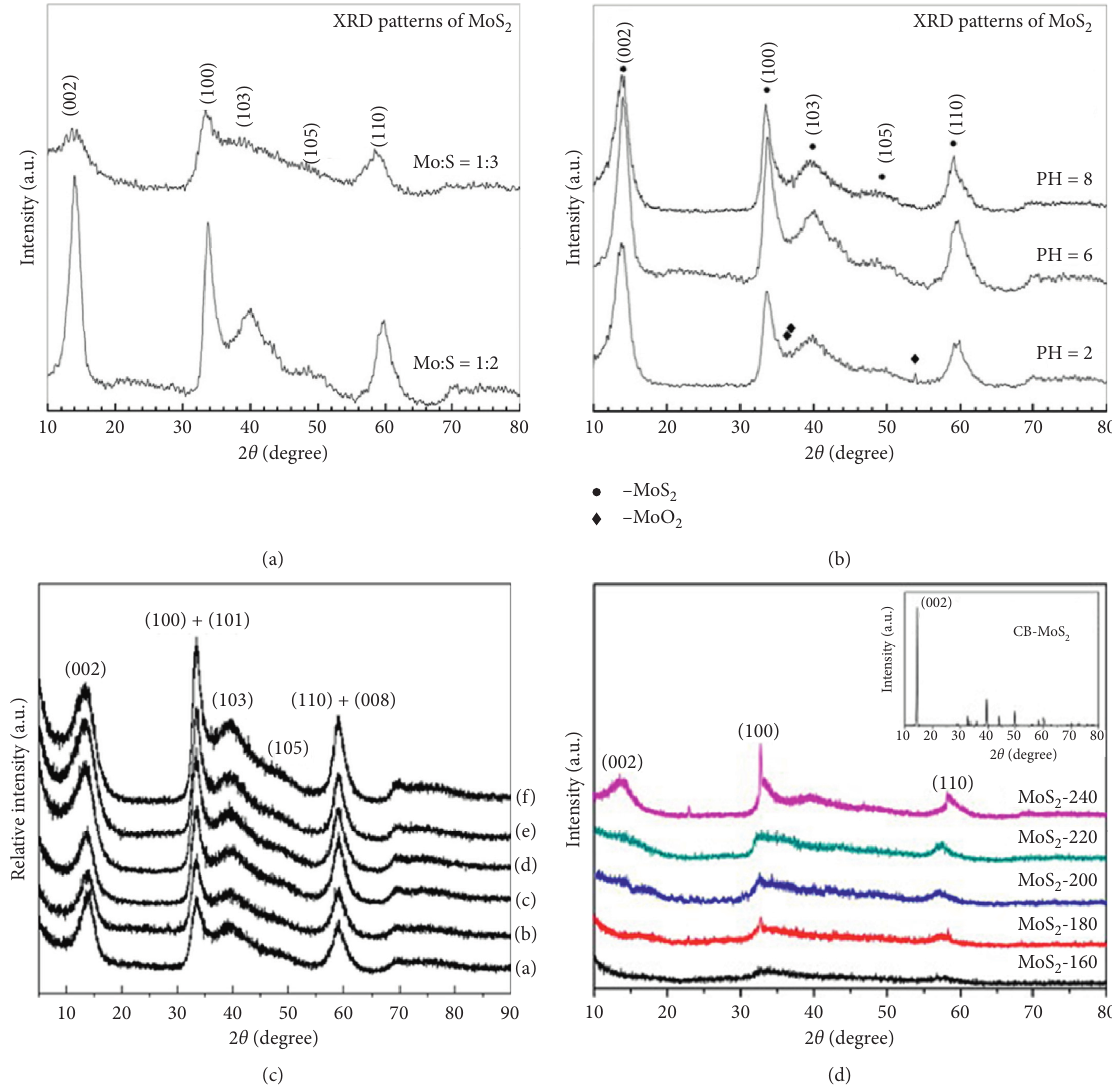
Figure 12: XRD pattern of MoS